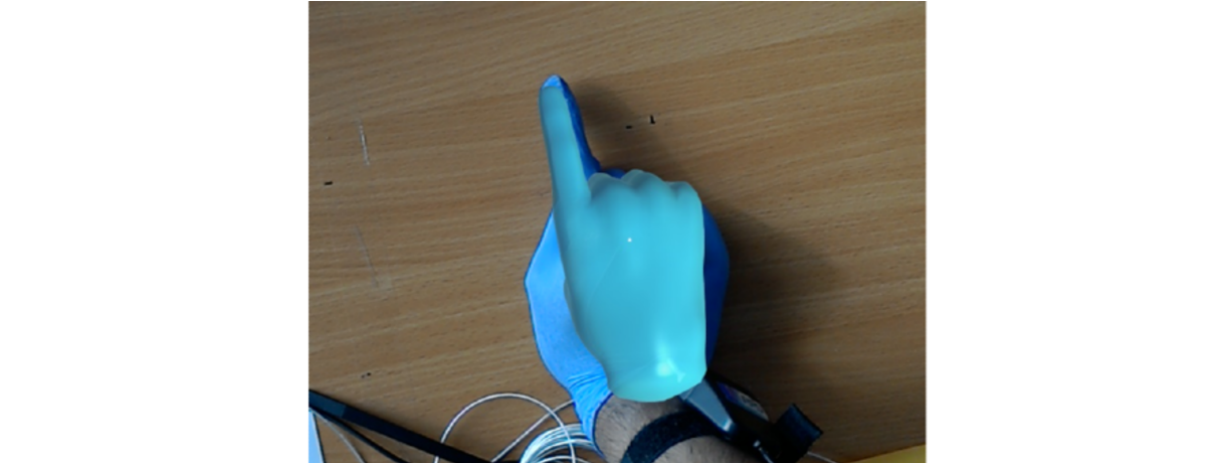
Figure 5. The virtual finger in blue overlaid onto the real examining finger with a blue medical glove.